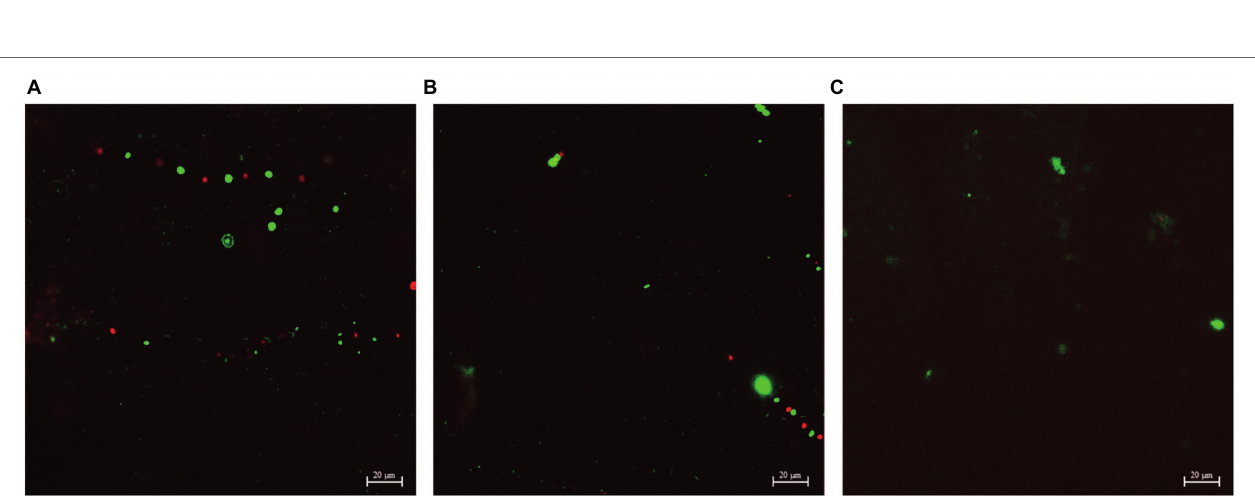
FIGURE 5 | CLSM biofilm images on NiMo coatings with different electrocodeposition conditions after 21-day SRB incubation at 37 ° C: (A) NiMo [DC], (B) NiMo [low f ], and (C) NiMo [high f